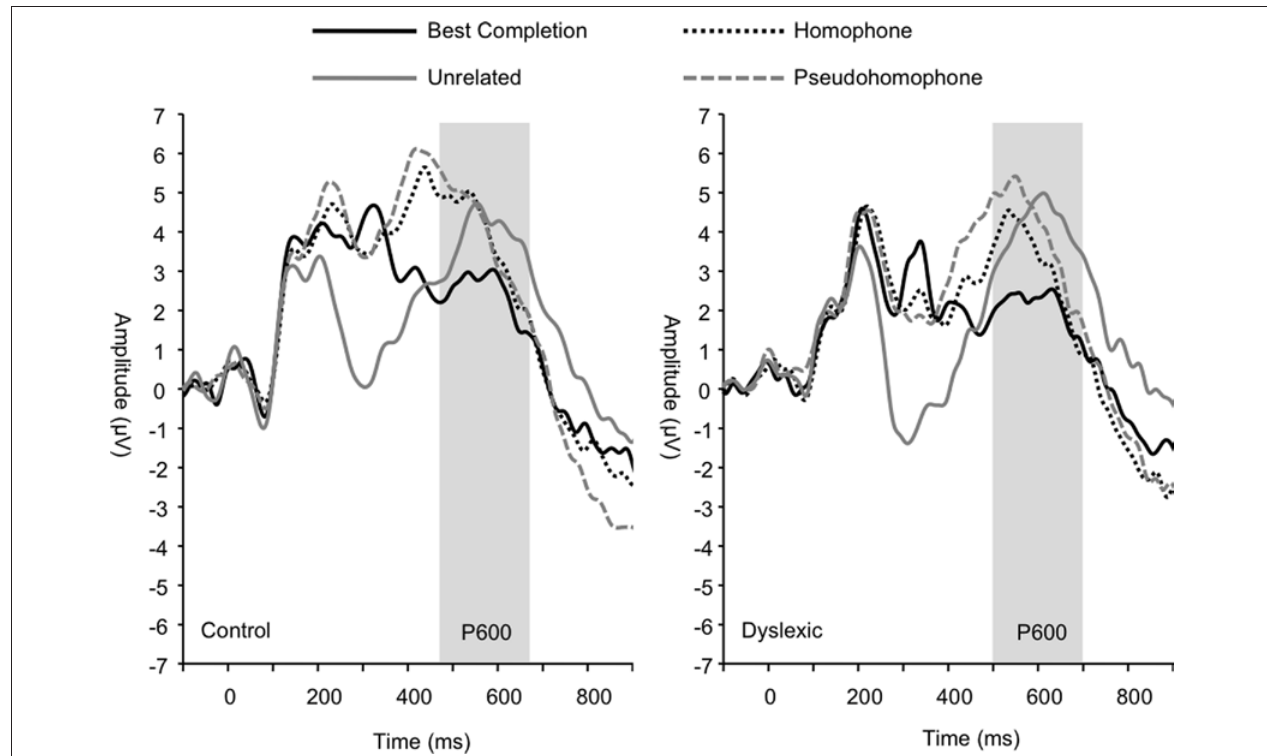
FiGure 6 | Group grand averages showing the P600 peak, marked by the gray bar. Linear derivation of CP3, CP4, CPz, and Pz